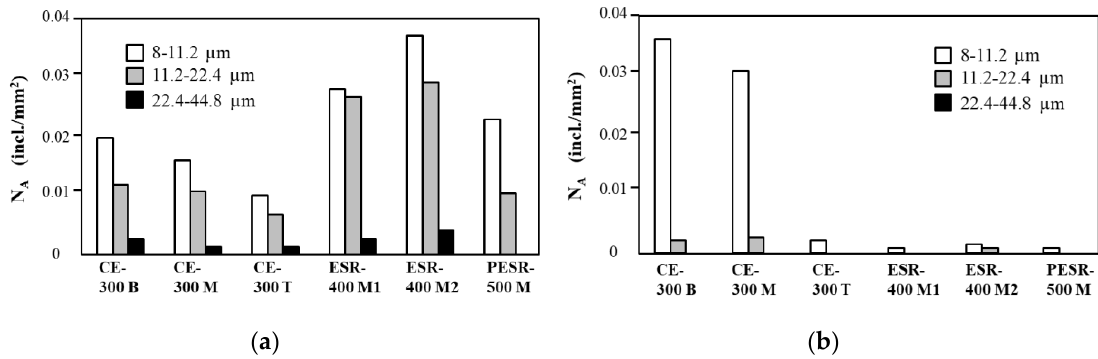
Figure 2. Number of ( a ) oxide and ( b ) sulfide inclusions per unit area (N A ) for the C-300, ESR-400 and PESR-500 samples. The amounts of sulfur in the steel [%S] in the ESR-400 and in the PESR-500 are 68% respectively 76% of the amount of sulfur [%S] in the CE-300.